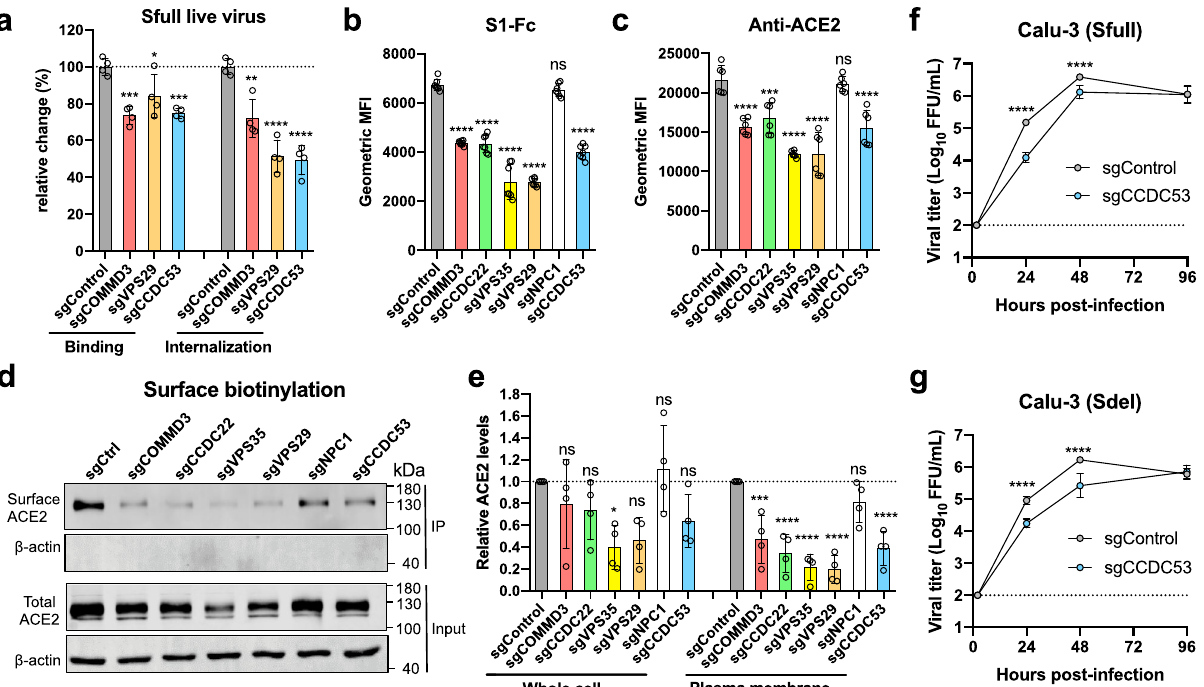
Fig. 4 Host genes that regulate the surface expression of receptor ACE2 are identi fi ed. a The effect on virion binding and internalization in gene-edited cells. A549-ACE2 cells were incubated with SARS-CoV-2 Sfull infectious virus on ice for binding or then switched to 37 °C for internalization. Viral RNA was extracted for RT-qPCR analysis (two experiments; n = 4; one-way ANOVA with Dunnett ’ s test; mean ± s.d.). b , c Surface expression of receptor ACE2 was decreased in gene-edited cells as measured by fl ow cytometry using S1-Fc recombinant protein or anti-ACE2 antibody (2 experiments; n = 7 ( b ) or 6 ( c ); one-way ANOVA with Dunnett ’ s test; mean ± s.d.). d , e Surface and total expression of receptor ACE2 were decreased in gene-edited cells. The plasma membrane proteins were biotin-labeled and immunoprecipitated by streptavidin beads for western blotting. One representative blot was shown ( d ) and data are pooled from four independent experiments, quanti fi ed, and normalized to the controls of individual experiments ( e ) (four experiments; n = 4; one-way ANOVA with Dunnett ’ s test; mean ± s.d.). f , g The impact on viral production in CCDC53 gene-edited Calu-3 cells. The mixed cell population was infected with Sfull ( f ) or Sdel ( g ) to assess the virus yield (two experiments; n = 6; two-way ANOVA with Sidak ’ s test). * P < 0.05; ** P